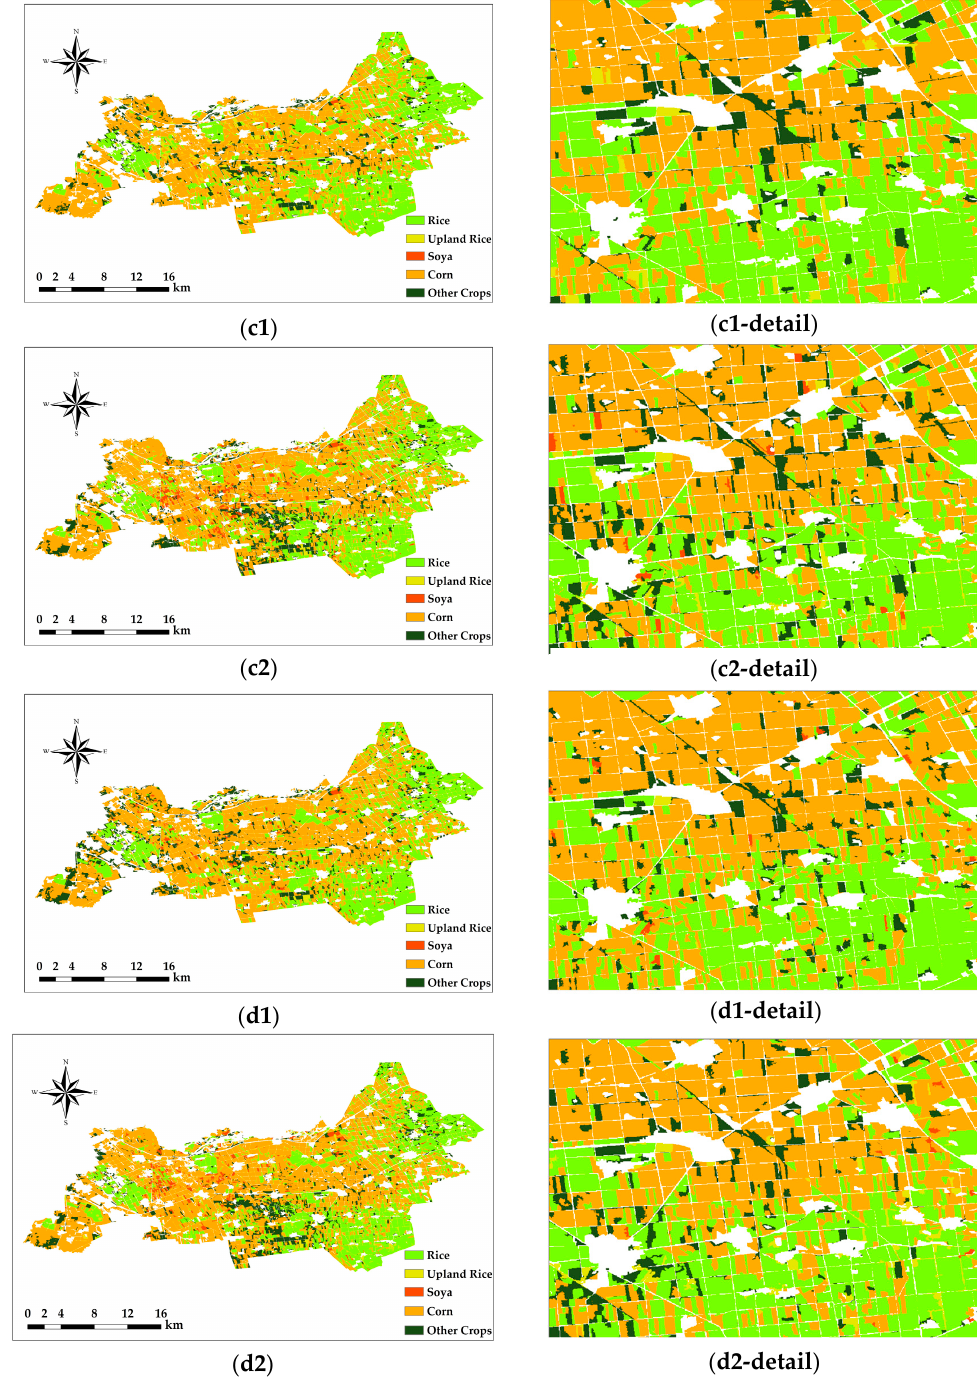
Figure 7. Object-oriented classification results. Pixel-based classification results. Only Sentinel-2 images were used in ( c1 , c2 ), Sentinel-1 SAR and Sentinel-2 images were used in ( d1 , d2 ), the RF method was used in ( c1 , d1 ), and the SVM method was used in ( c2 , d2 ). The number of each figure corresponds to that in Table 5.